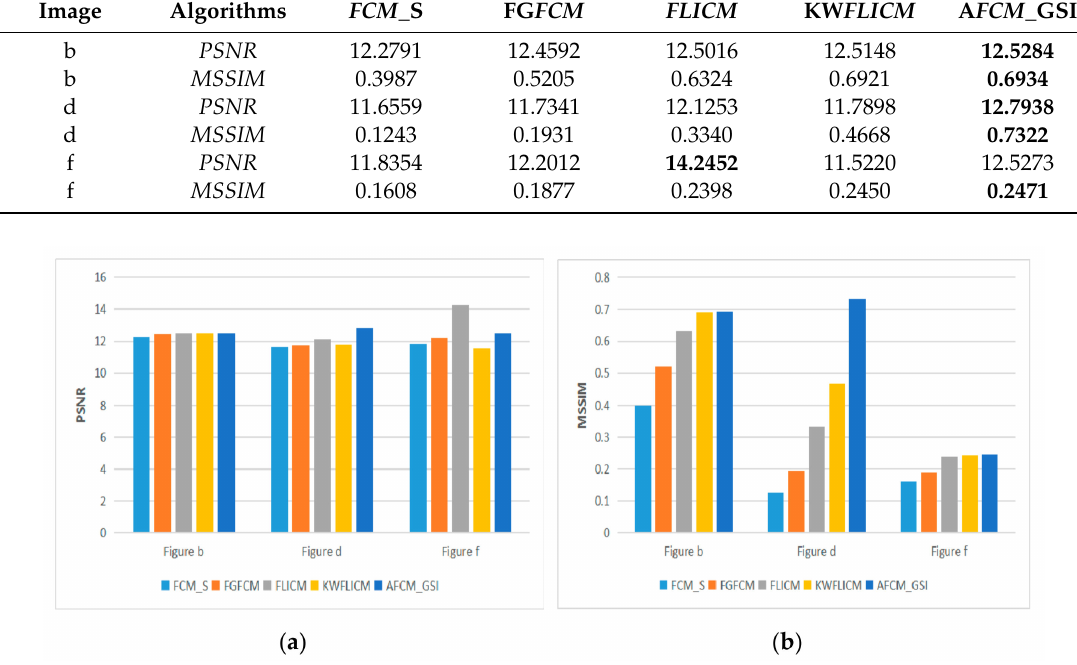
Figure 7. PSNR and MSSIM of five algorithms on noisy natural images and remote sensing image